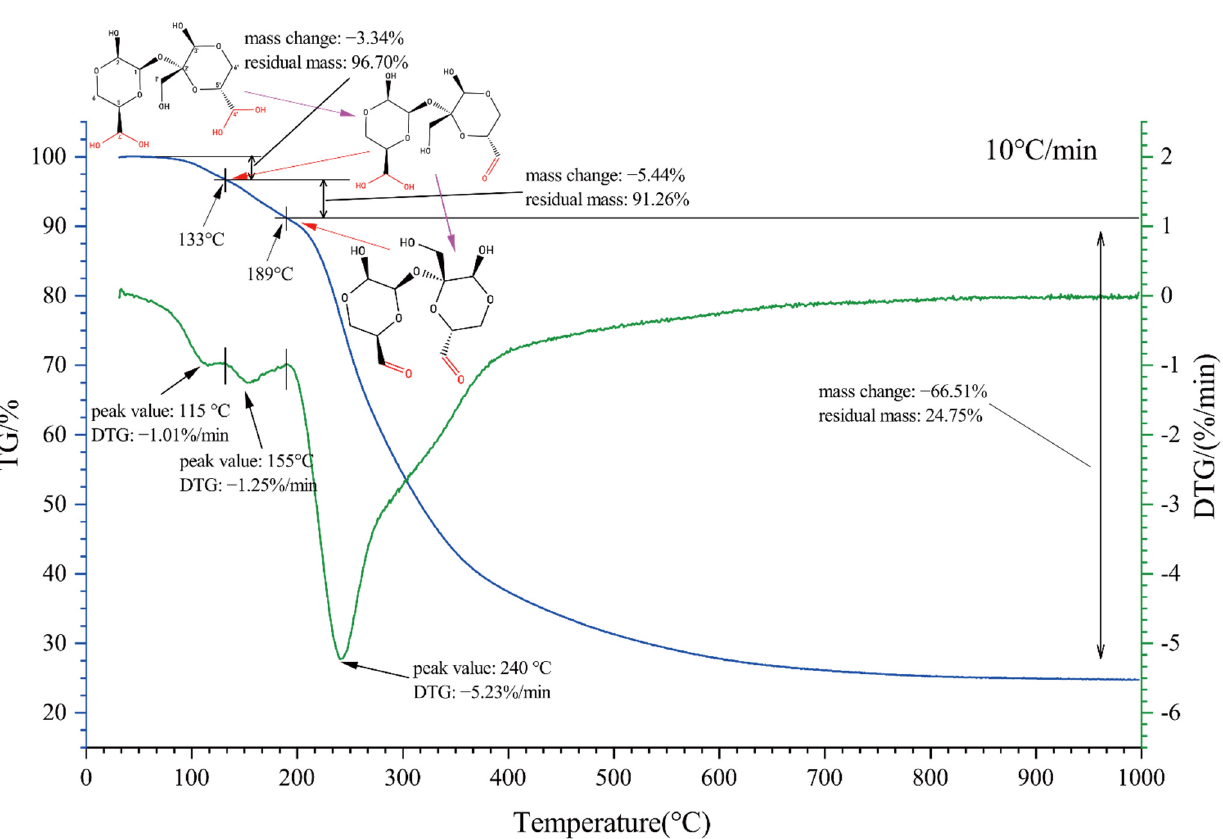
Figure 6. Thermogravimetric analysis of